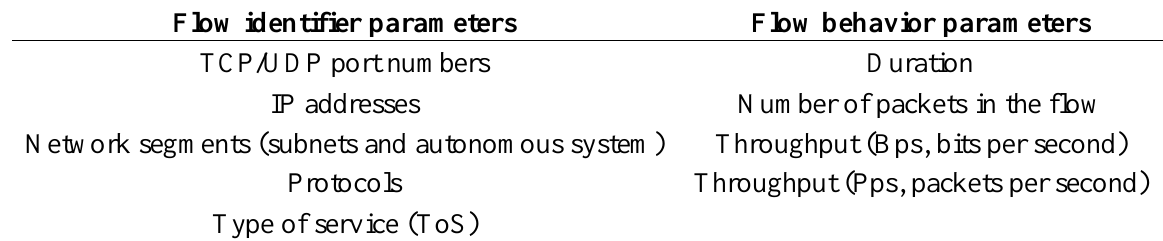
Table 1. Network parameters to detect elephant